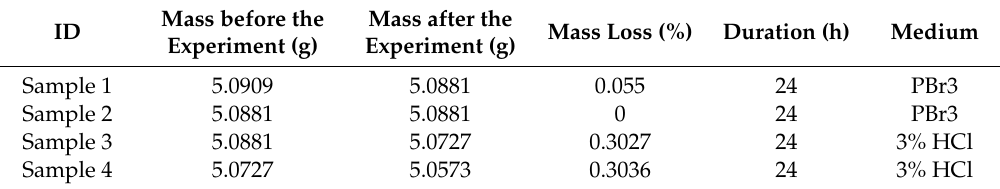
Table 3. Experimental results of corrosion resistance of